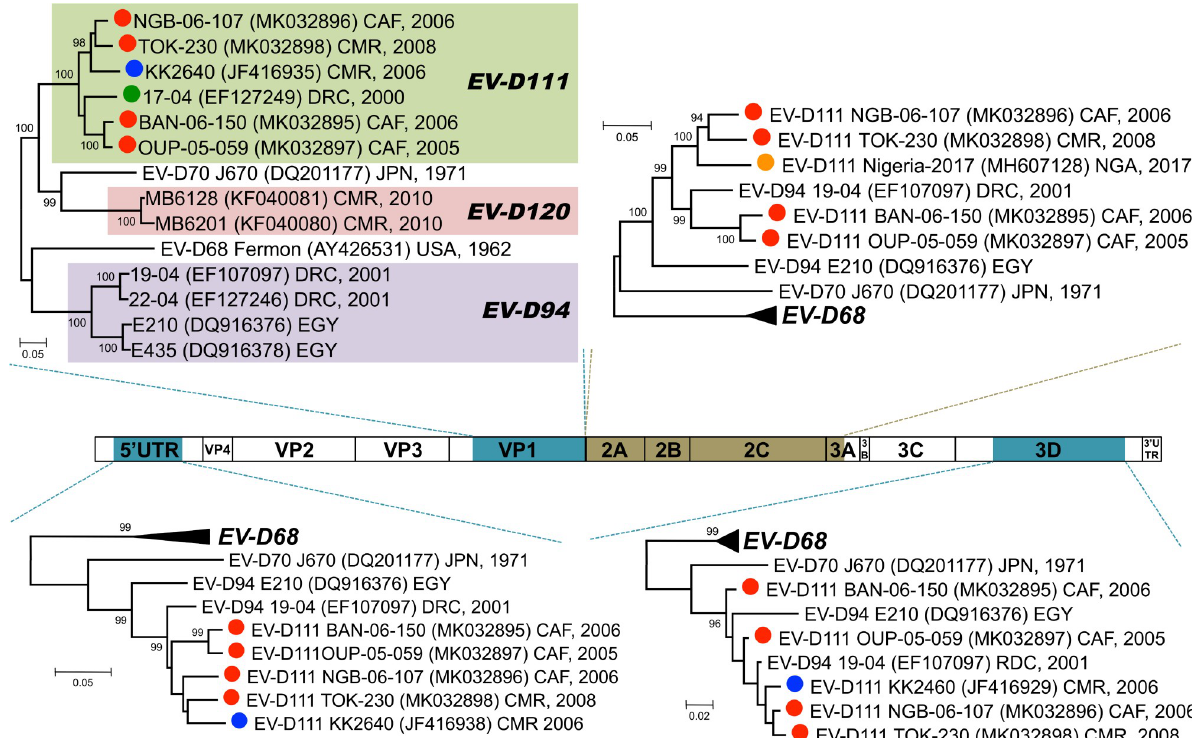
Fig 5. Phylogenetic trees based on different genomic regions. The organization of the enterovirus genome is schematized in the middle of the picture; the genomic regions used to draw the phylogenetic trees are shaded. In the trees, the EV-D111 labels are colour-coded according the colours used in Fig